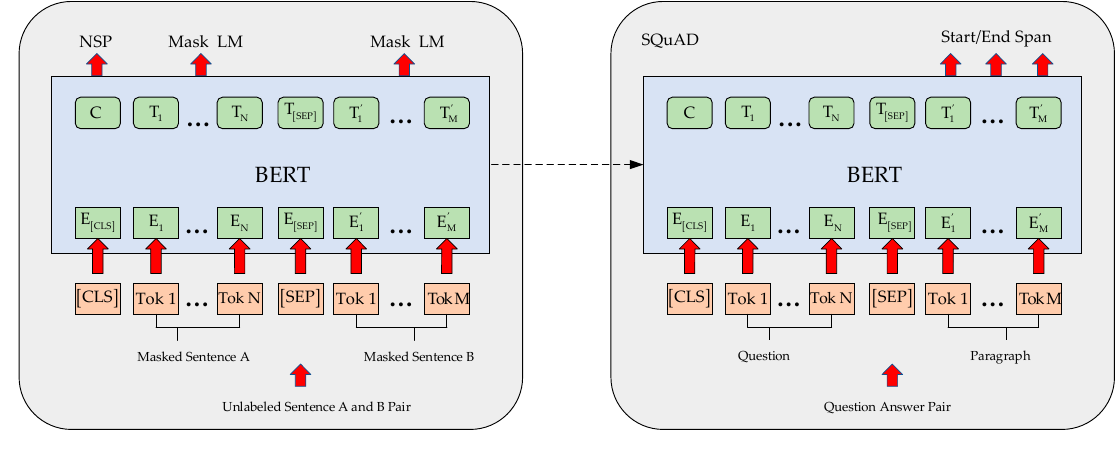
Figure 2. BERT pre-training/fine tuning flow chart.